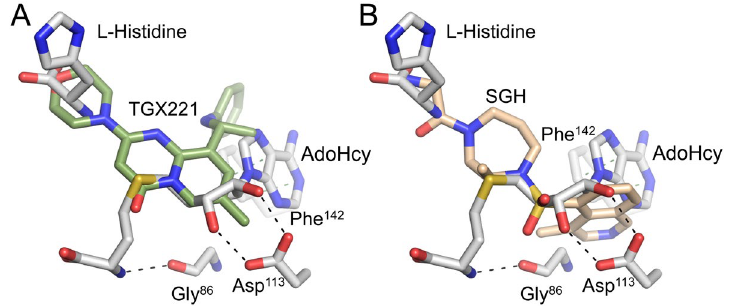
Figure 11. Required interactions for EgtD active site closing. ( A ) Super position of M. tb EgtD-TGX221 complex (green carbons) with closed M. smegmatis EgtD complex (gray carbons) ( B ) Super position of M. tb EgtD-SGH complex (tan carbons) with closed M. smegmatis EgtD complex (gray). The indicated polar (black dashed bonds) and non-polar interactions (green dashed bonds) are required for EgtD active site closing. Each of the interactions are lacking in both the TGX221 and SGH inhibitor